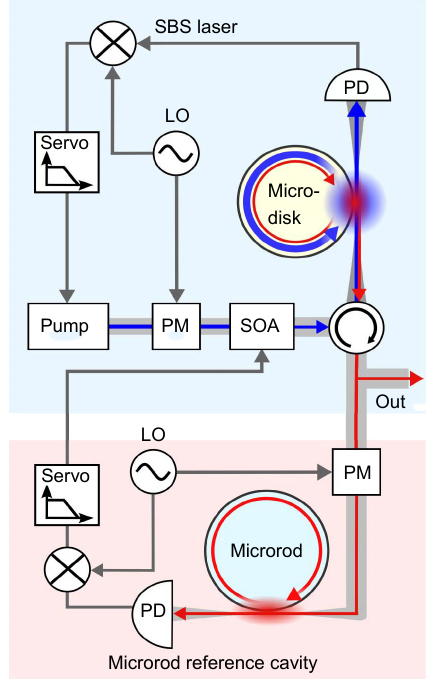
Fig. 8 | Diagram and operation of the dual-microcavity narrow- linewidth laser . Figure reproduced with permission from ref. 7 , The Optical